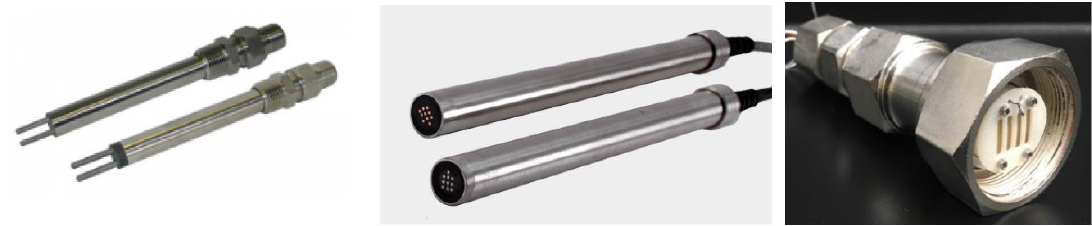
Figure 3. Variations of the electrochemical sensors. Reproduced with permission from [77] Copyright 2019 AIP Publishing.